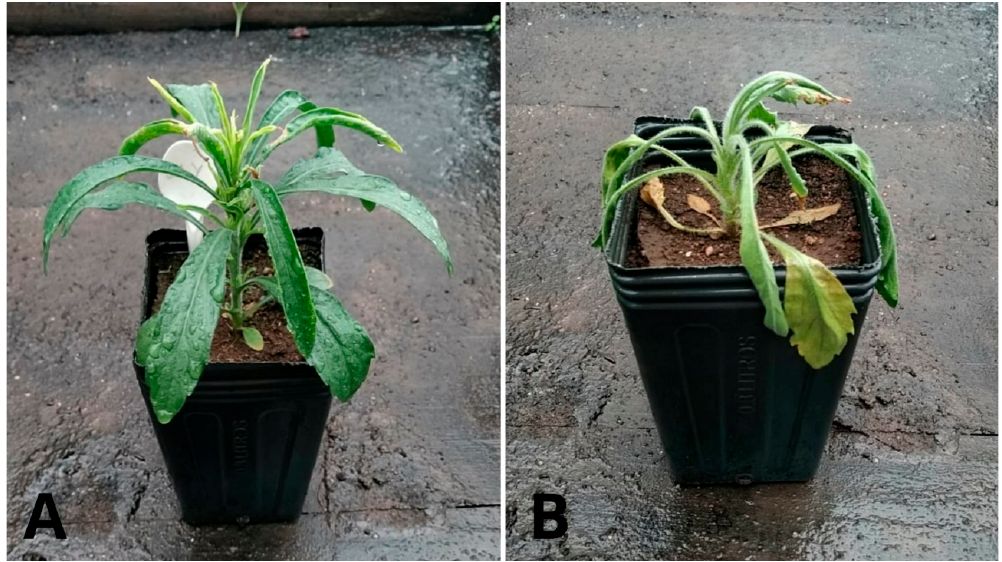
Figure 4. Resistant ( A ) and susceptible ( B ) Conyza spp. biotypes exposed to 1080 g glyphosate (ea) ha − 1 for 12 days.